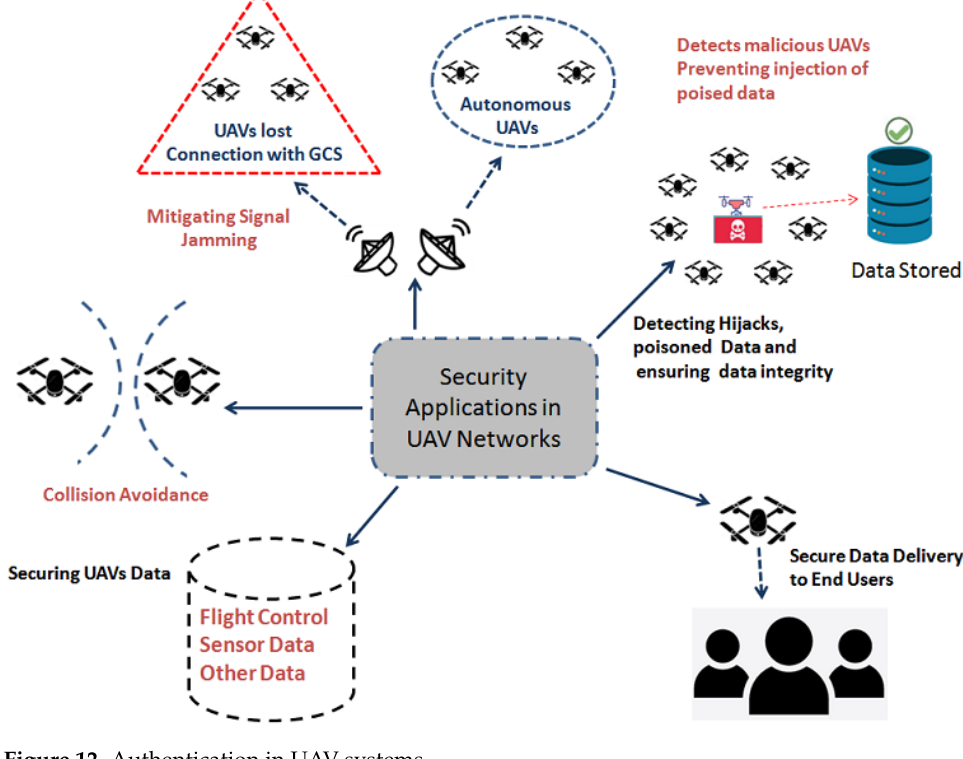
Figure 12. Authentication in UAV systems. Table 2. Lightweight